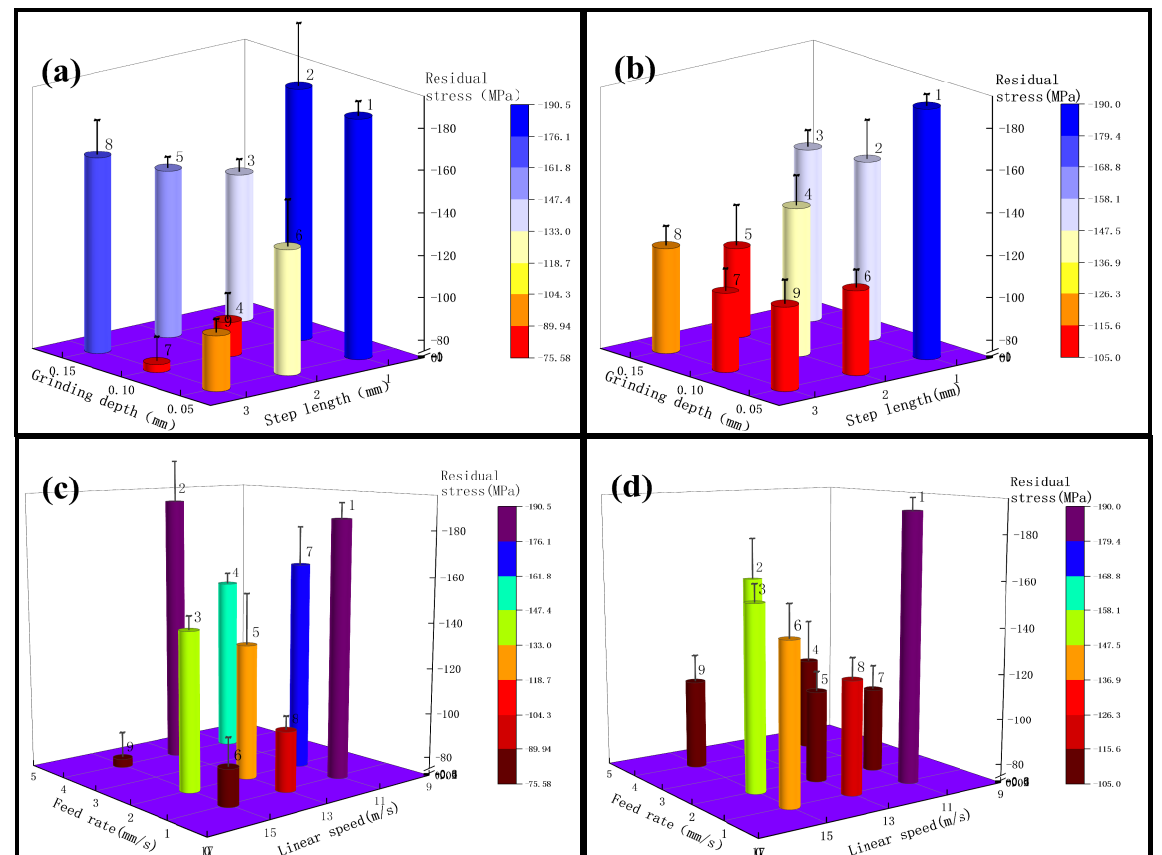
Figure 6. ( a ) for test 1, variables are grinding depth and step length, ( b ) for test 3, variables are grinding depth and step length; ( c ) for test 1, variables are linear speed and feed rate, ( d ) for test 3, variables linear speed and feed rate.